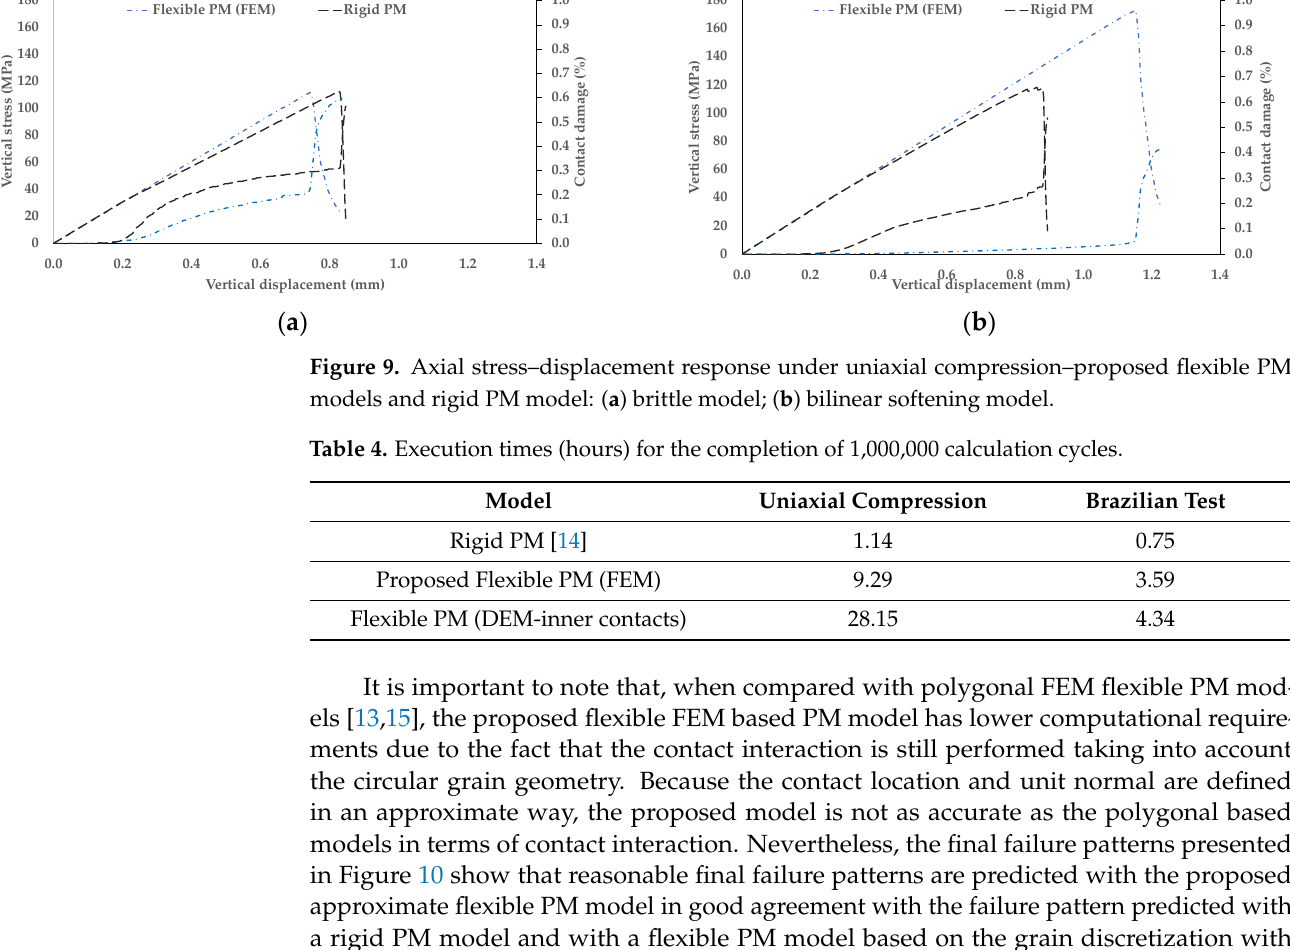
Table 4. Execution times (hours) for the completion of 1,000,000 calculation cycles.